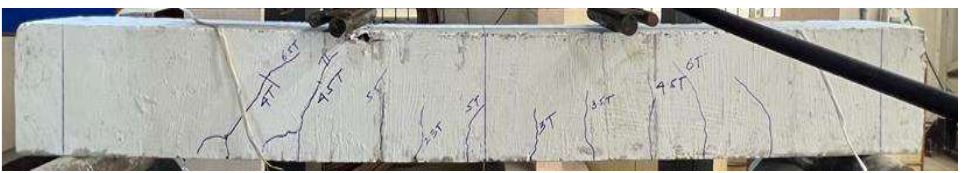
Figure 9. Lightweight Concrete Beam.